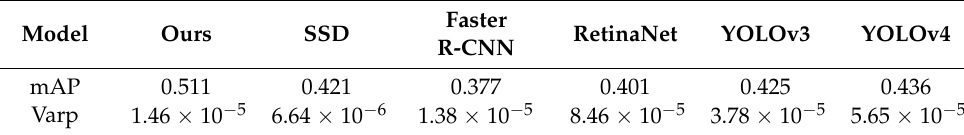
Table 4. Detection result of some classical deep-learning-based detectors (with 5-fold cross